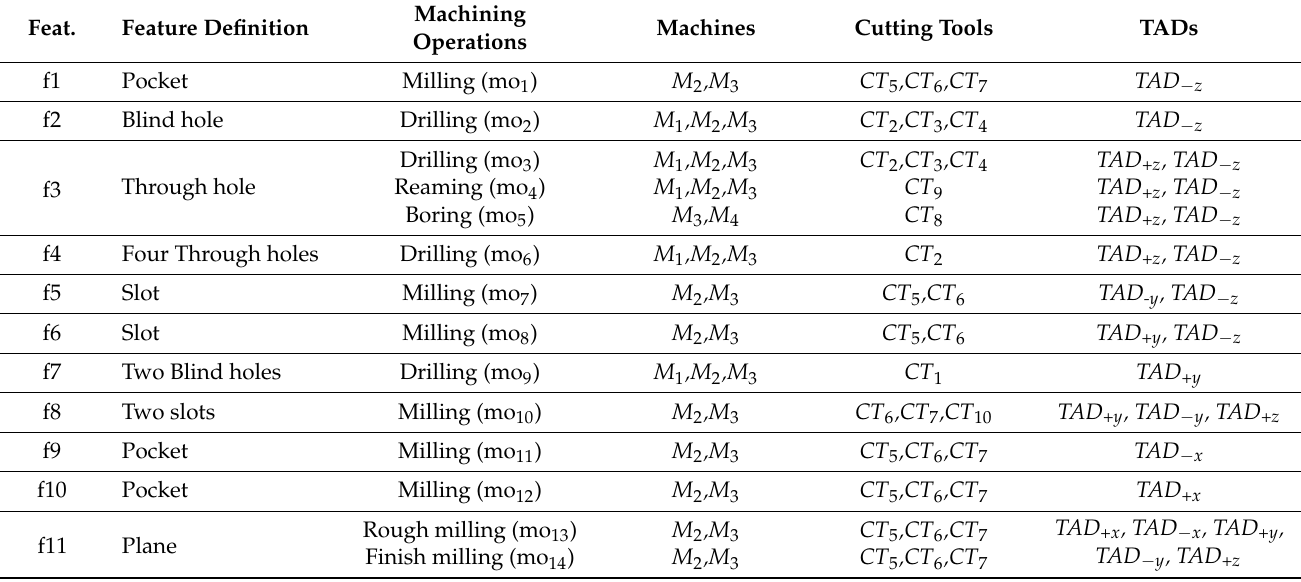
Table 5. Information about features and resource candidates for prismatic part 3.